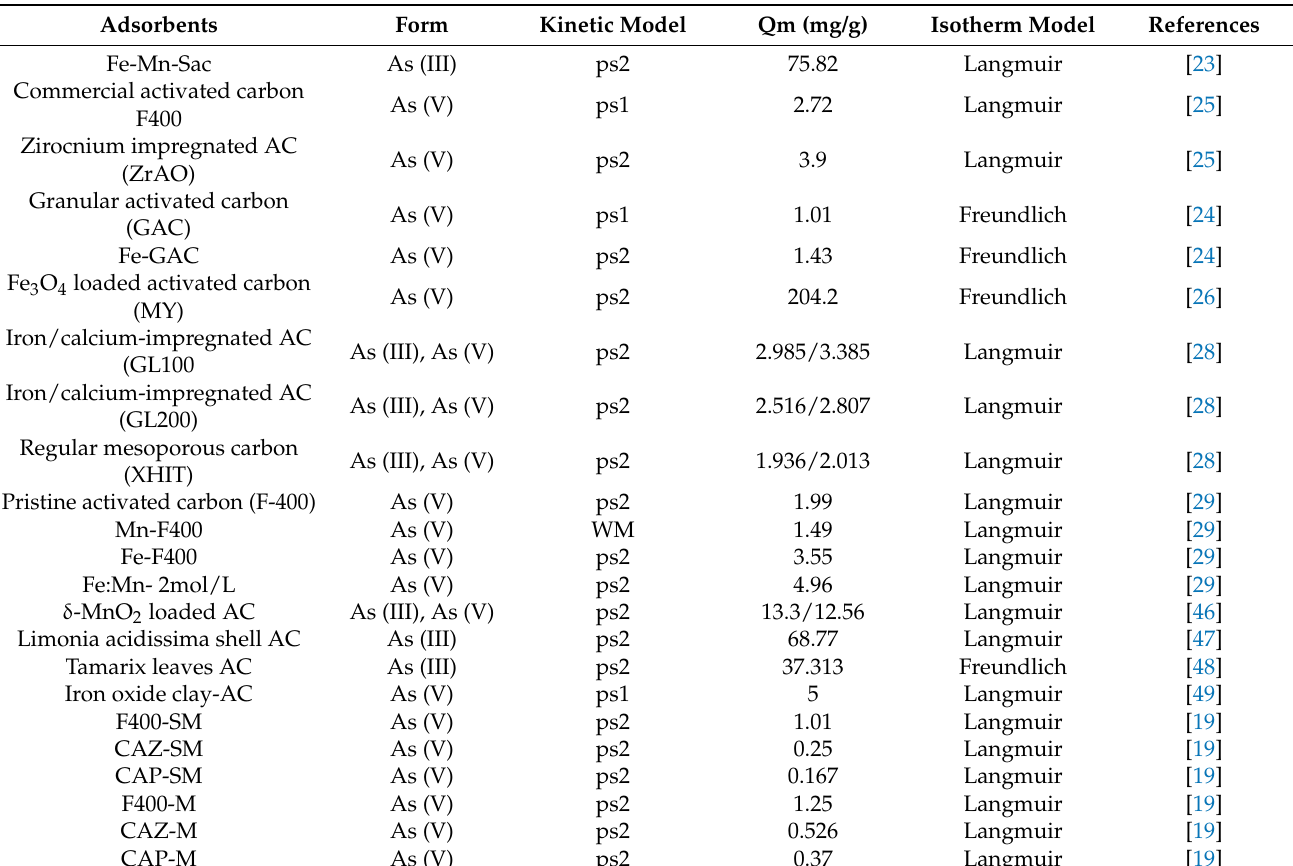
Table 2. Kinetics model, adsorption isotherm and maximum Langmuir adsorption capacity of some adsorbents based on AC for arsenic removal (WM corresponds to the Weber–Morris equation